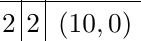
n 1 . The gluing curve (cid:0)